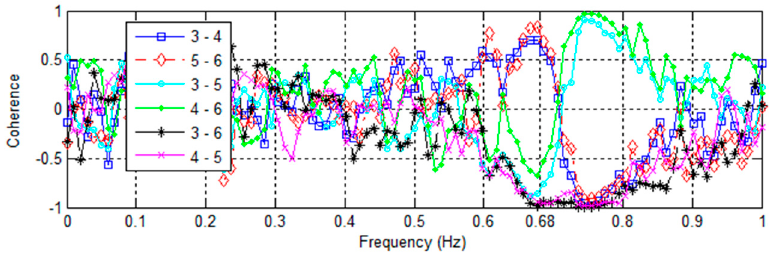
Figure 16. Coherence between vertically-aligned accelerometers in the basement of the Green Building subjected to the 4th of July fireworks show.